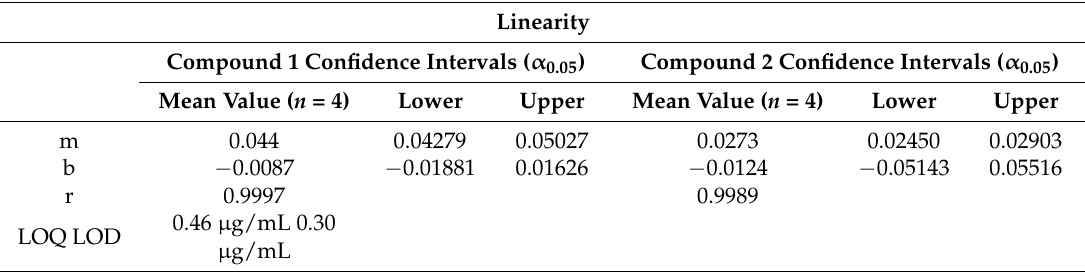
Table 4. Linearity of quantitation method used for Compound 1 and the Compound 2 in rat plasma and confidence intervals (CI 95%) for slope and